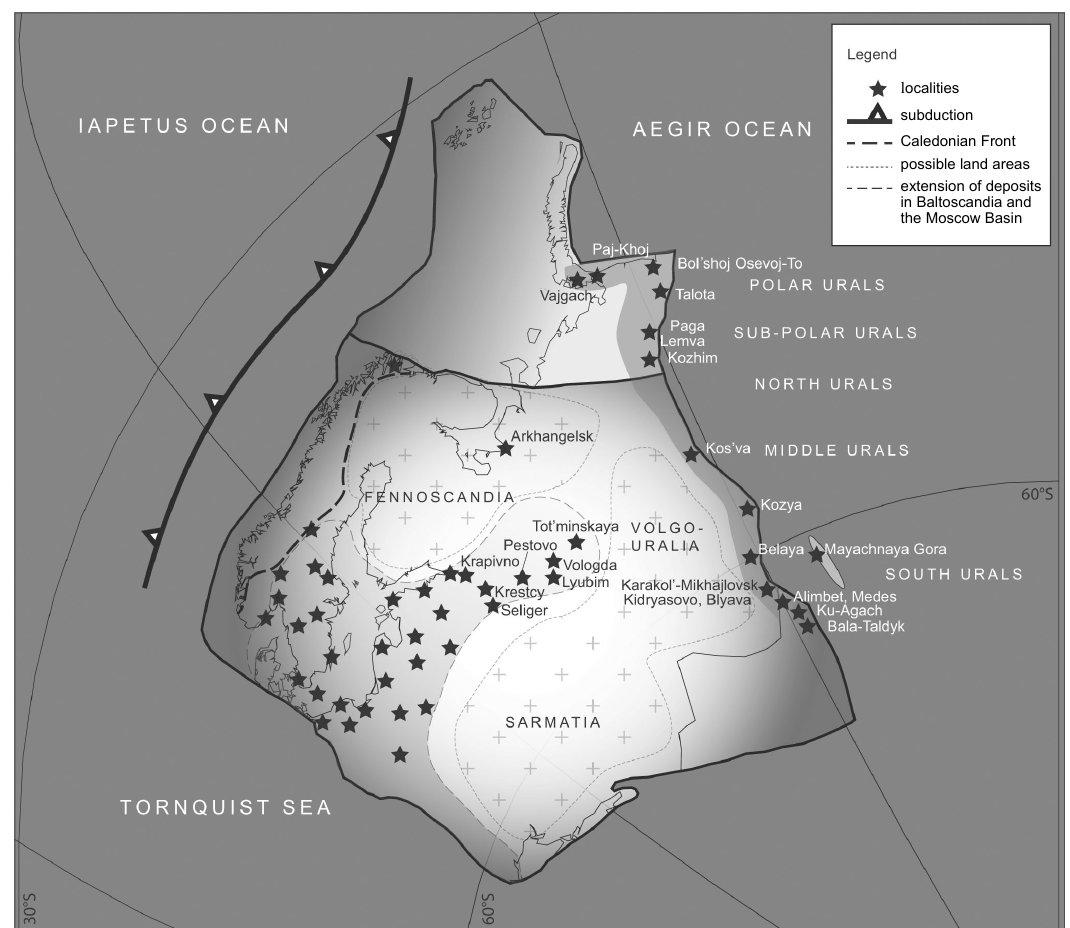
Fig. 1. The Baltica continent in the early Ordovician with its complex borders and development of restricted marine sedimentary rocks in Baltoscandia in the west, the Moscow Basin deep within the plate and the Uralian belts in the